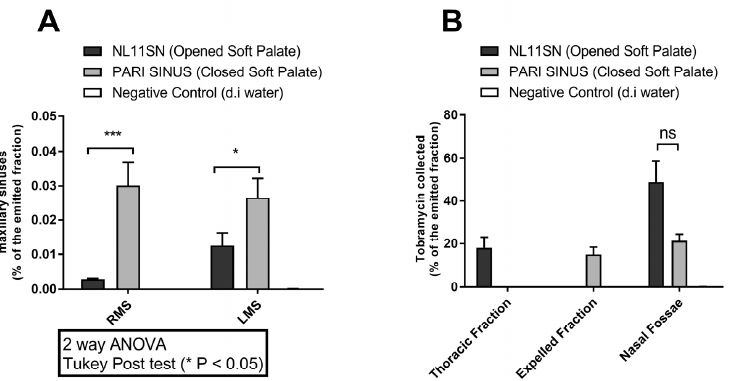
Figure 3. Comparison of results obtained for the tobramycin deposition with the NL11SN device and the PARI SINUS device. ( A ) Maxillary sinus deposition (RMS = right maxillary sinus; LMS = left maxillary sinus). ( B ) Amount of tobramycin collected in the thoracic fraction (only for opened soft palate condition), in the expelled fraction, and in the nasal fossae. Results are expressed in percentage of the emitted fraction. Negative control corresponds to deionized water nebulization. Statistically different from control cells: *** p < 0.001, * p < 0.05.